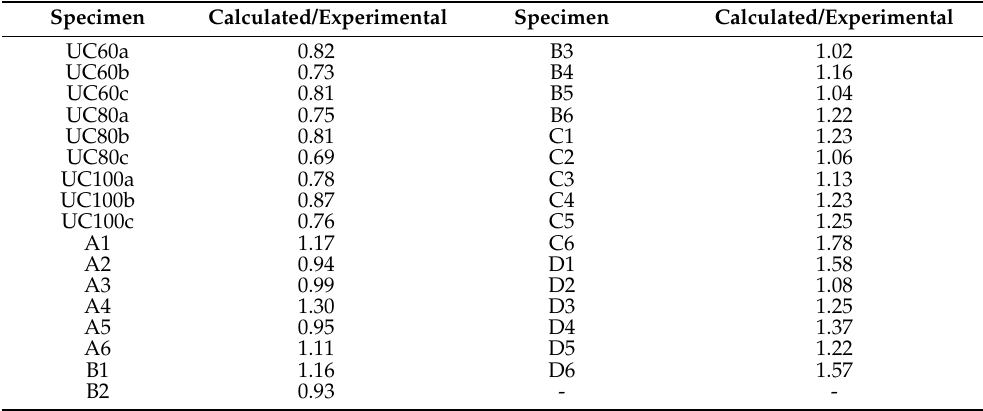
Table 3. Comparison of calculated values and experimental values based on the EC2 code.